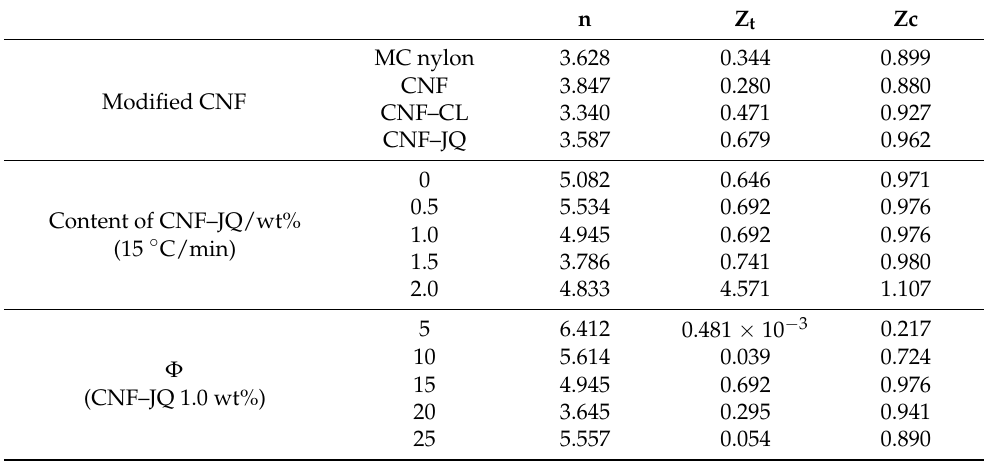
Table 3. Crystallization kinetic parameters from Jeziorny’s model.